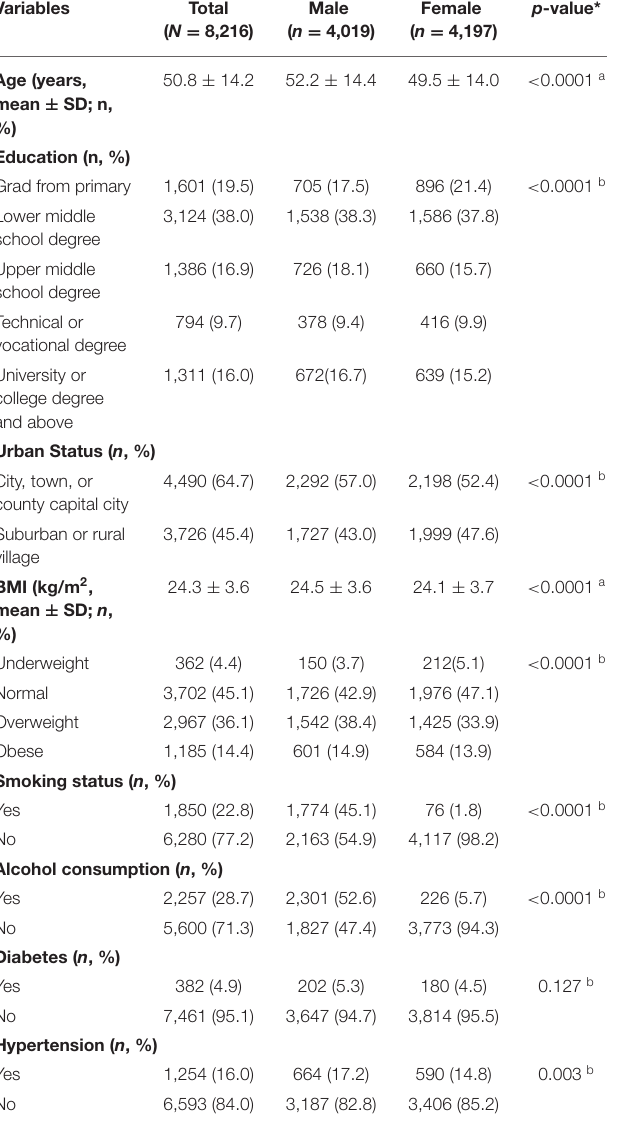
TABLE 1 | The basic characteristics of selected participants. TABLE 2 | The comparison of perceived stress with different basic characteristics